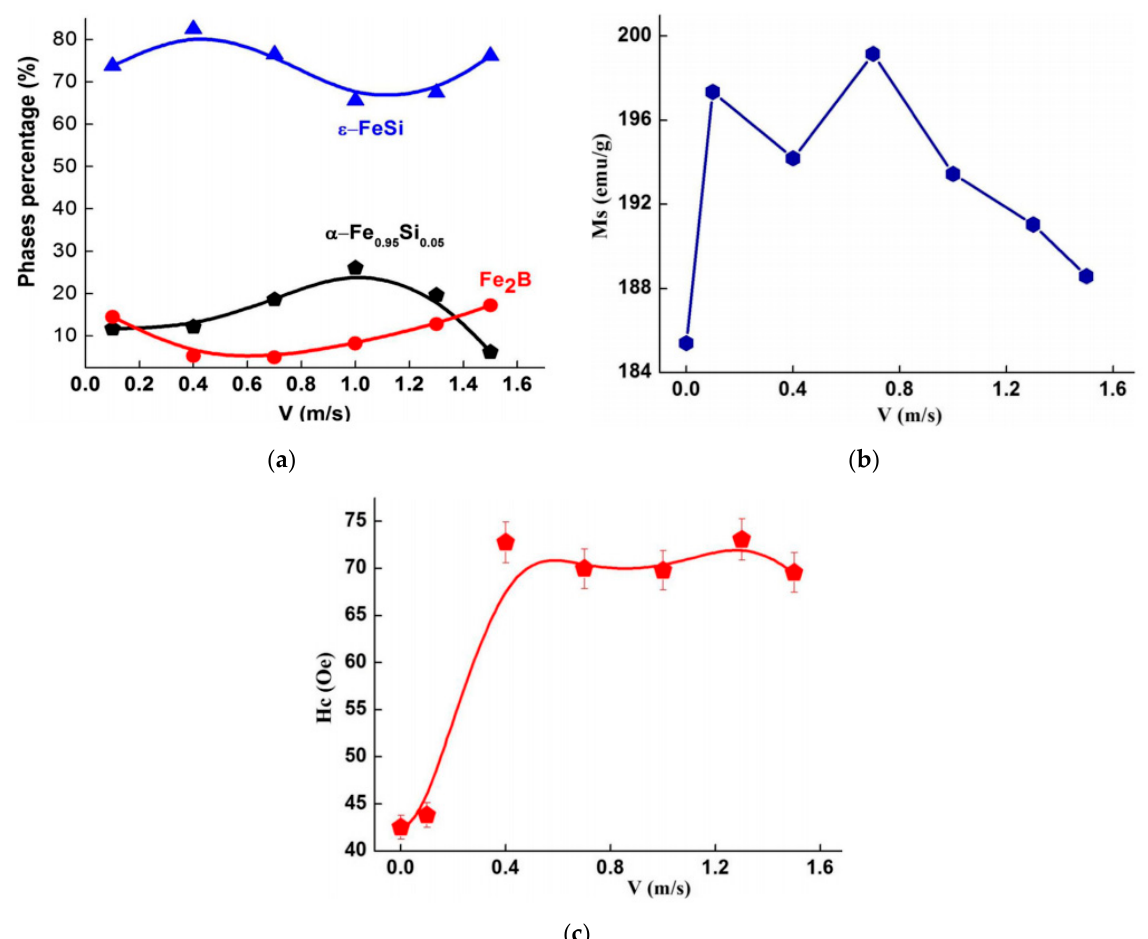
Figure 8. ( a ) Evolution of the relative proportions of the phases, ( b ) saturation magnetisation alterations and ( c ) coercivity changes of the selectively laser-melted Fe 92.4 Si 3.1 B 4.5 specimens as a function of laser scan speed, reprinted with the permission from [68], Springer, 2018 (CGS to SI conversion 1 emu/g = 1 Am 2 /kg and 1 Oe = 79.6 A/m).